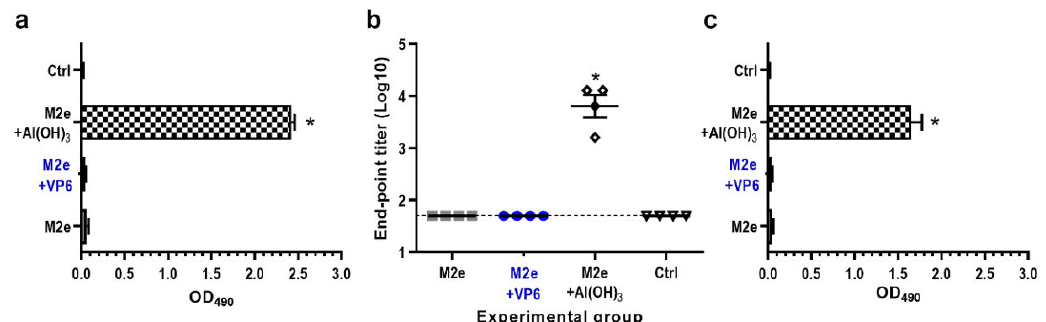
Figure 5. Development of serum antibody responses against M2e following two immunizations with M2e alone or in combination with VP6 or Al(OH) 3 . Control (Ctrl) received no immunogen. ( a ) Group mean OD 450 values with standard errors of the means of IgG antibodies in 1:100 diluted termination sera. ( b ) Endpoint titers of serum IgG antibodies in termination sera. Each symbol represents an individual mouse. The solid line indicates the geometric mean titer of the group. A titer of 50 (1.7 log 10 ) was assigned for sera with no detectable antibodies, being a half of the initial serum dilution. Horizontal dashed line indicates the cut-o ff level (1.7 log 10 ). ( c ) Cross-reactive serum IgG responses against heterologous M2e peptide derived from swine influenza virus. Shown are group mean OD 490 values with standard errors of the means of IgG antibodies in 1:100 diluted termination sera. * indicates statistically significant ( p > 0.05) di ff erences between the